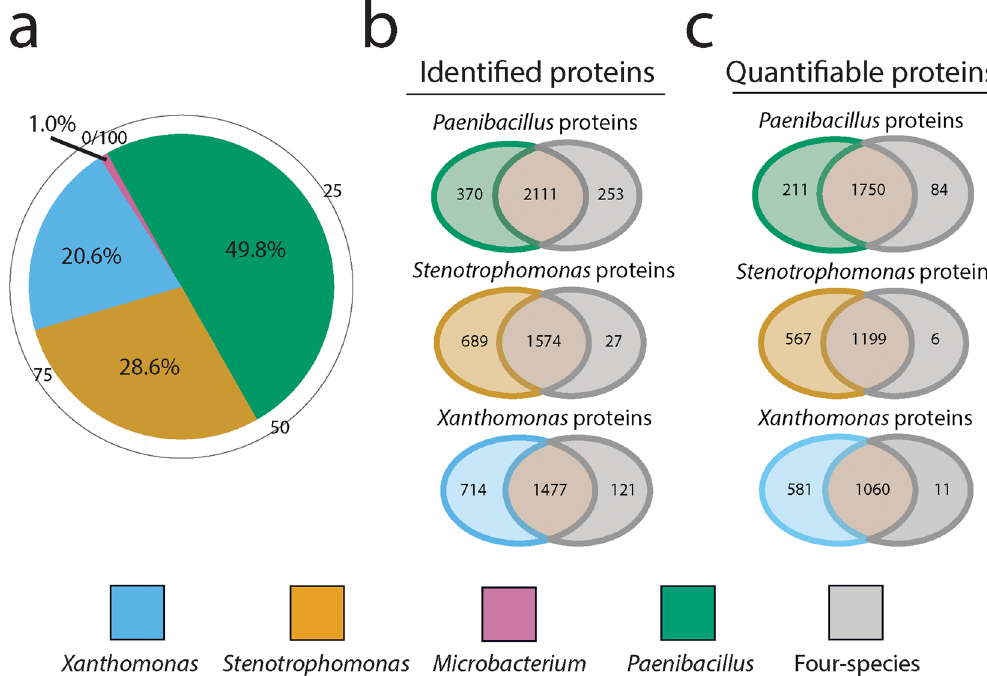
Figure 2. ( a ) Species composition in the four-species biofilm based on intensity of identified proteins from the four-species biofilm. ( b ) Protein overlap of identified proteins between single and four-species biofilm. More proteins were identified in the single species biofilm compared to the four-species biofilm. The majority of identified proteins were shared between single and four-species biofilm. ( c ) Protein overlap of quantifiable proteins between single and four-species biofilm. Quantifiable proteins comprised proteins occurring in at least 60% of biological replicates from each single and four-species biofilm.